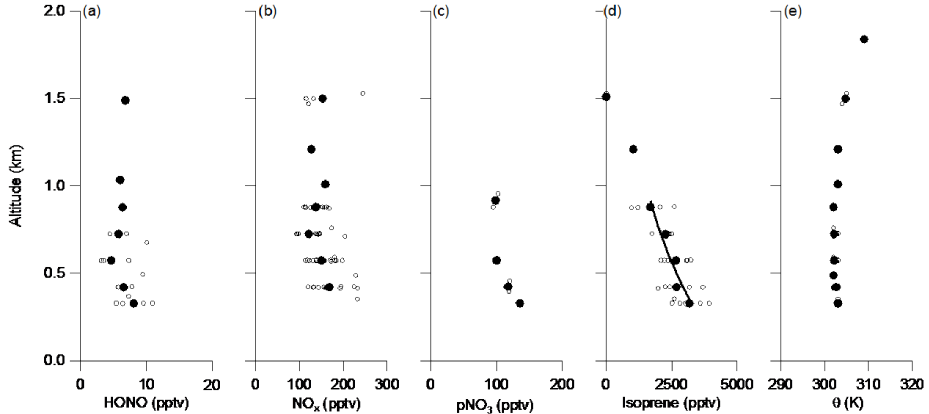
Figure 4. Vertical distributions of concentrations of HONO (a) , NO x (b) , p NO 3 (c) , isoprene (d) and potential temperature (e) in the PBL during the first racetrack of RF 4 from 11:00 to 12:15 LT (16:00–17:15UTC), 12 June 2013. The small open circles represent the time- averaged data of 1min for NO x , isoprene and potential temperature, 3min for HONO, and 6min for p NO 3 . The large solid circles the mean values for each racetrack measurement altitude. The line in (d) is the best fit of Eq. (1) to the isoprene data: C = 4700e − h/ 0 . 895 , r 2 = 0 . 93.